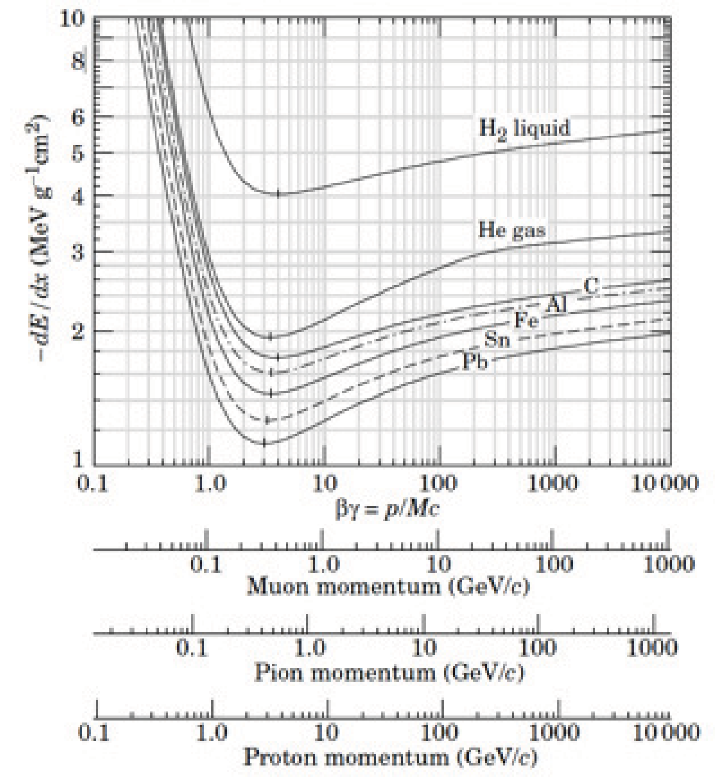
Figure 6. The energy loss for various particles in various materials as calculated using the Bethe